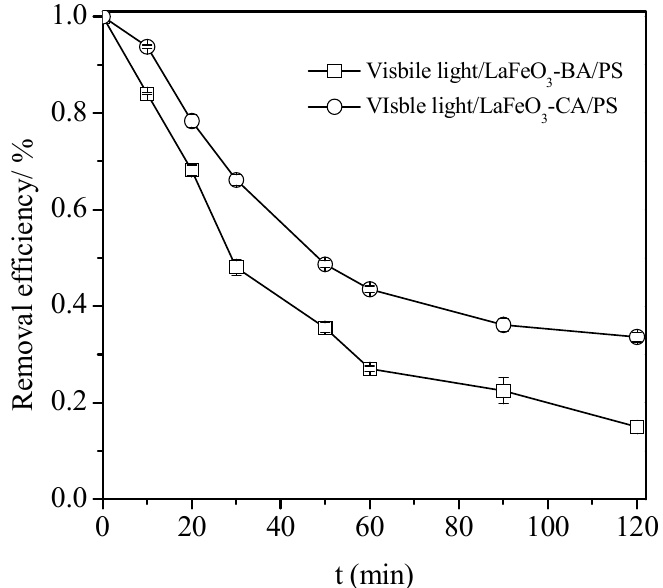
Figure 5. Impact of the preparation method on the catalyst efficiency in the visible light/PS/catalyst process for the tetracycline degradation. Conditions: C 0 = 100 mg L − 1 , catalyst (BA or CA) = 0.5 g L − 1 , [PS] = 50 mmol L − 1 , and pH 0 = 3.7.